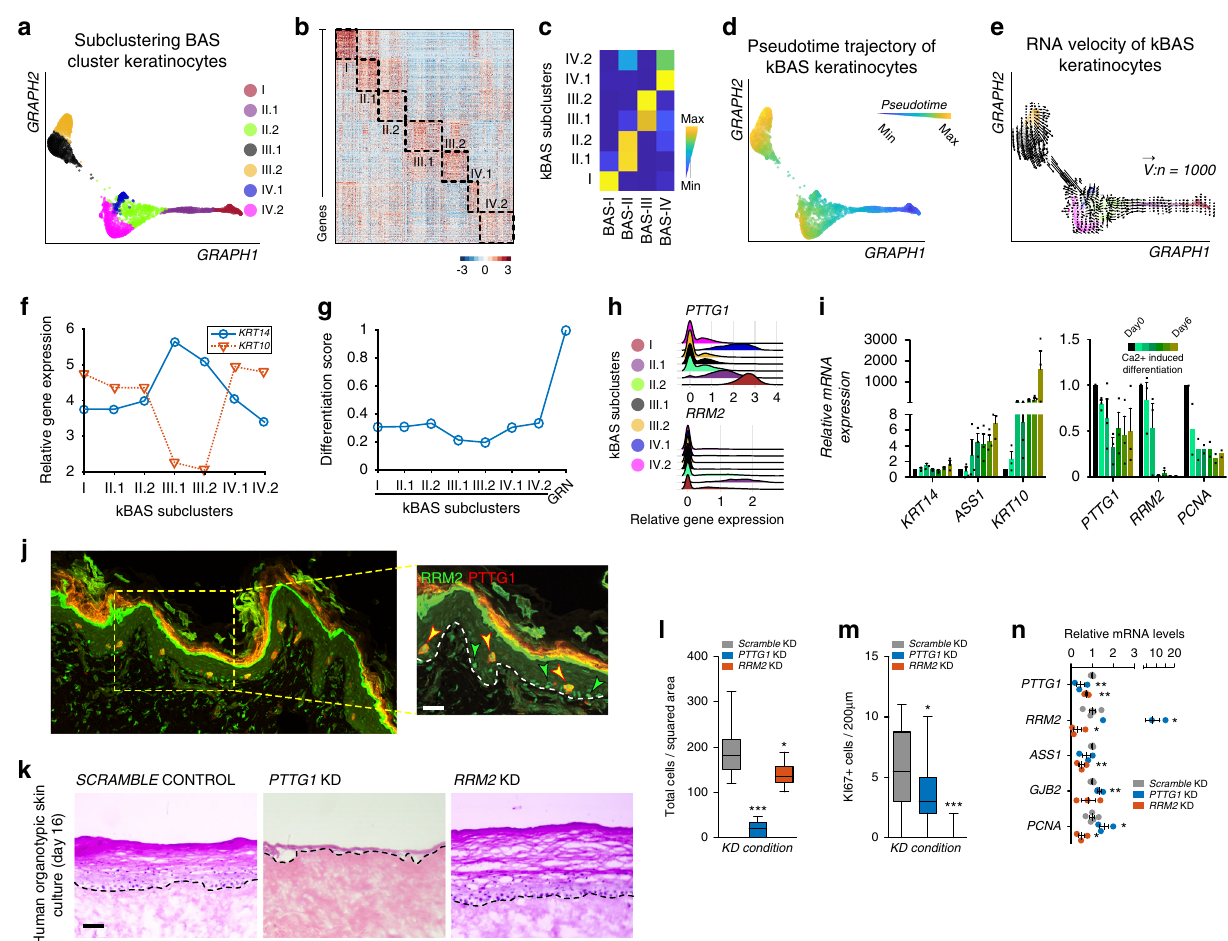
Fig. 5 Subclustering basal stem cells point to the BAS-I cluster as essential to epidermal homeostasis. a Subclustering basal clusters (BAS-I – BAS-IV) using SoptSC. b Heatmap showing top 100 differentially expressed genes per cluster. c Correlation between overlapping differentially expressed genes from basal clusters and subclustering of basal clusters (kBAS) in A. d Pseudotime inference of kBAS keratinocytes. e RNA velocity of kBAS keratinocytes using 1000 vectors. Cells color-coded as in A. f Relative gene expression of KRT14 and KRT10 across the kBAS subclusters. g Differentiation score of kBAS subclusters using average gene expression of GRN genes. h Violin plot of relative gene expression of PTTG1 and RRM2 across kBAS subclusters. i Relative mRNA expression of indicated genes along Ca 2 + -induced differentiation of primary human keratinocytes. n = 3 experiments each time point ( n = 2 for PCNA ). j Coimmunostaining of PTTG1 (red) and RRM2 (green) in human neonatal skin. Green arrowheads highlight RRM2-only expressing cells; yellow arrowheads point to PTTG1-RRM2 double-positive cells. White dotted line denotes basement membrane. Scale bar 50 µ m. n = 3. k Knock-down (KD) of PTTG1 and RRM2 , with a scramble control, in human skin equivalent organoids grown for 16 days. Hematoxylin and eosin (H&E) staining shown. Dotted lines denote basement membrane. Scale bar 100 µ m. n = 4 experiments each condition. l Quanti fi cation of total cells per squared area (* p = 0.0104; *** p < 0.0001; n = 12 areas each [ PTTG1 and RRM2 KD]), ( m ) KI67 + cells per 200 µ m area along the basement membrane (* p = 0.0123; *** p < 0.0001; n = 26 areas [ PTTG1 ] or n = 25 areas [ RRM2 ]), and ( n ) qPCR of the respective transcripts for each KD condition ( PTTG1 : p = 0.0056, 0.0018; RRM2 : p = 0.0485, 0.025; ASS1 : p = 0.0025; GJB2 : p = 0.0037; PCNA : p = 0.0339, 0.0295; n = 3 experiments each [ PTTG1 and RRM2 KD]). For whisker and box plots: box represents 25th to 75th percentiles, whiskers represent minimum and maximum data points, and bar represents mean. For bar graph: error bar represents SEM. For scatter plot: data are presented as mean values ± SEM. Signi fi cance was determined by unpaired two-tailed t